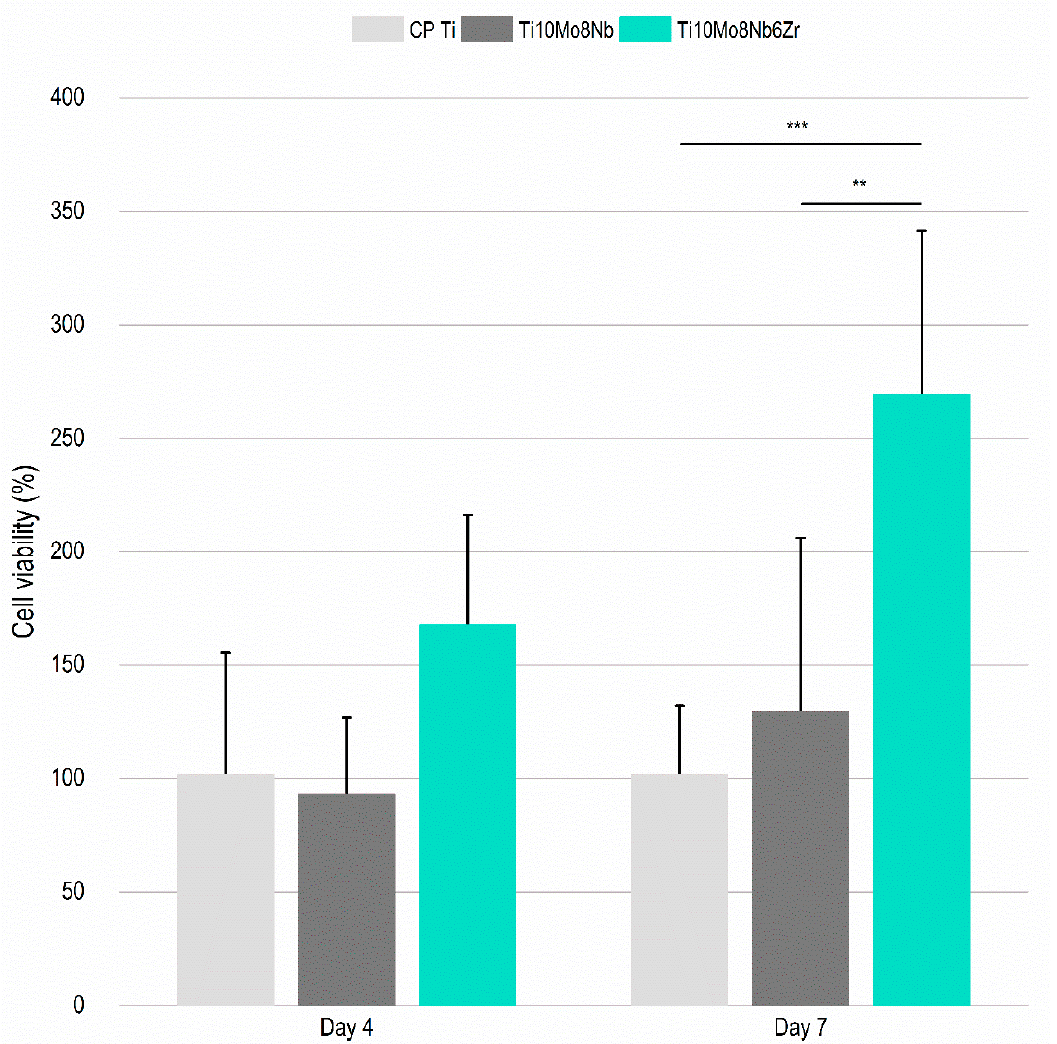
Figure 7. Cell growth on the surface of the Ti 10 Mo 8 Nb 6 Zr alloy. Cell viability after four and seven days of ADSC culture about the growth of cells on the surface of the CP TI about the cells on the surface of the Ti 10 Mo 8 Nb and Ti 10 Mo 8 Nb 6 Zr alloys. (**) p < 0.01, (***) p < 0.001 using the Mann–Whitney non-parametric test for independent samples, SPSS 13.0 software. The columns indicate the average values, and the bars indicate the standard deviation.